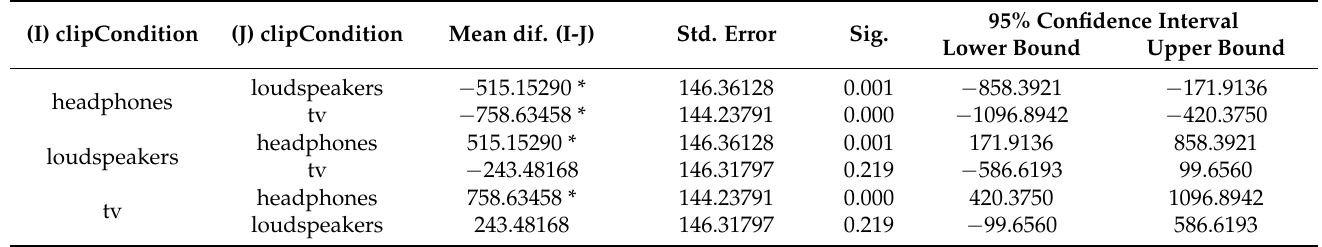
Table A4. Tukey’s HSD test multiple comparisons on listening